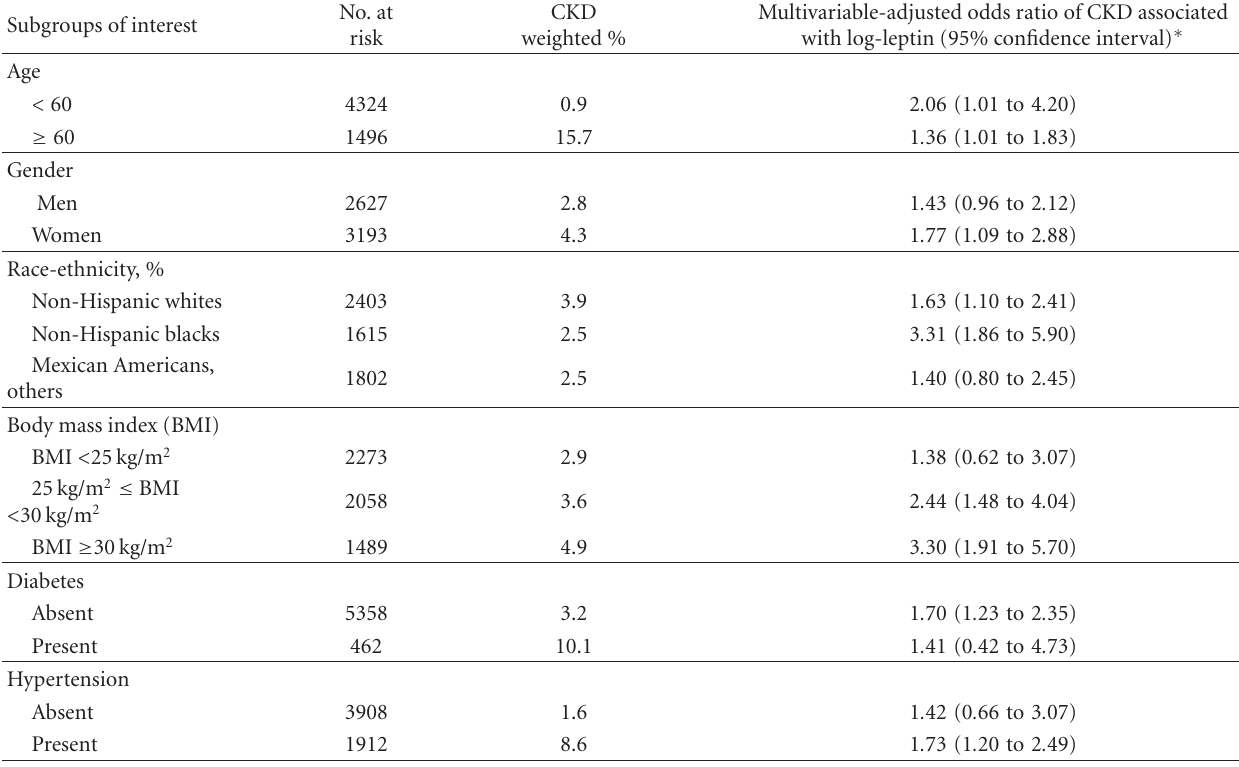
Table 3: Association between plasma leptin level and chronic kidney disease (CKD), by